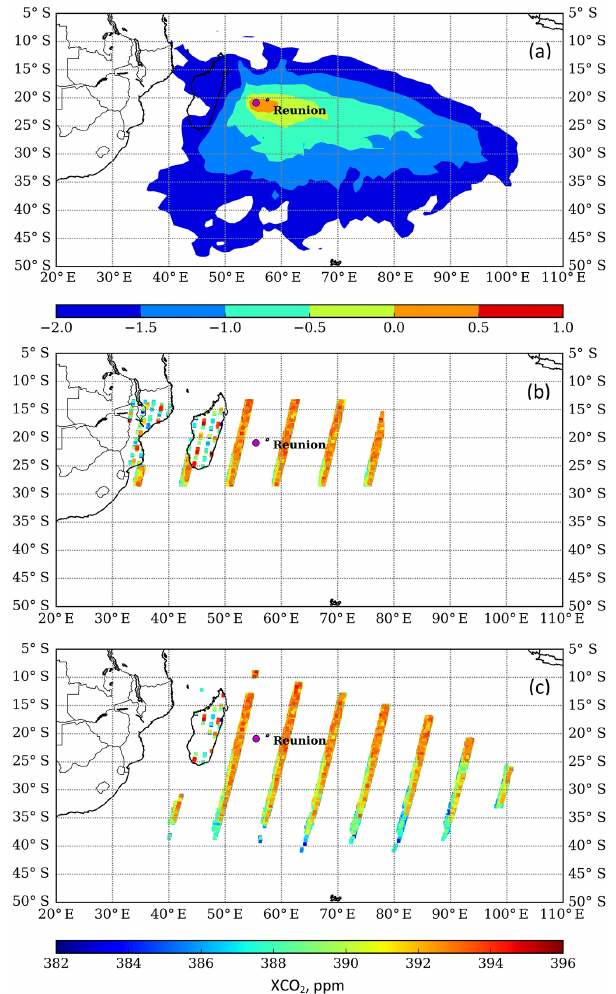
Figure 8. (a) Annual average footprint for the Reunion Island TCCON observation site; ACOS GOSAT XCO 2 observations se- lected using (b) the geostatistical method within an area of ± 7.5 ◦ ×± 22.5 ◦ and (c) the footprint-based method with the limit log 10 ( x ) =− 2.0.